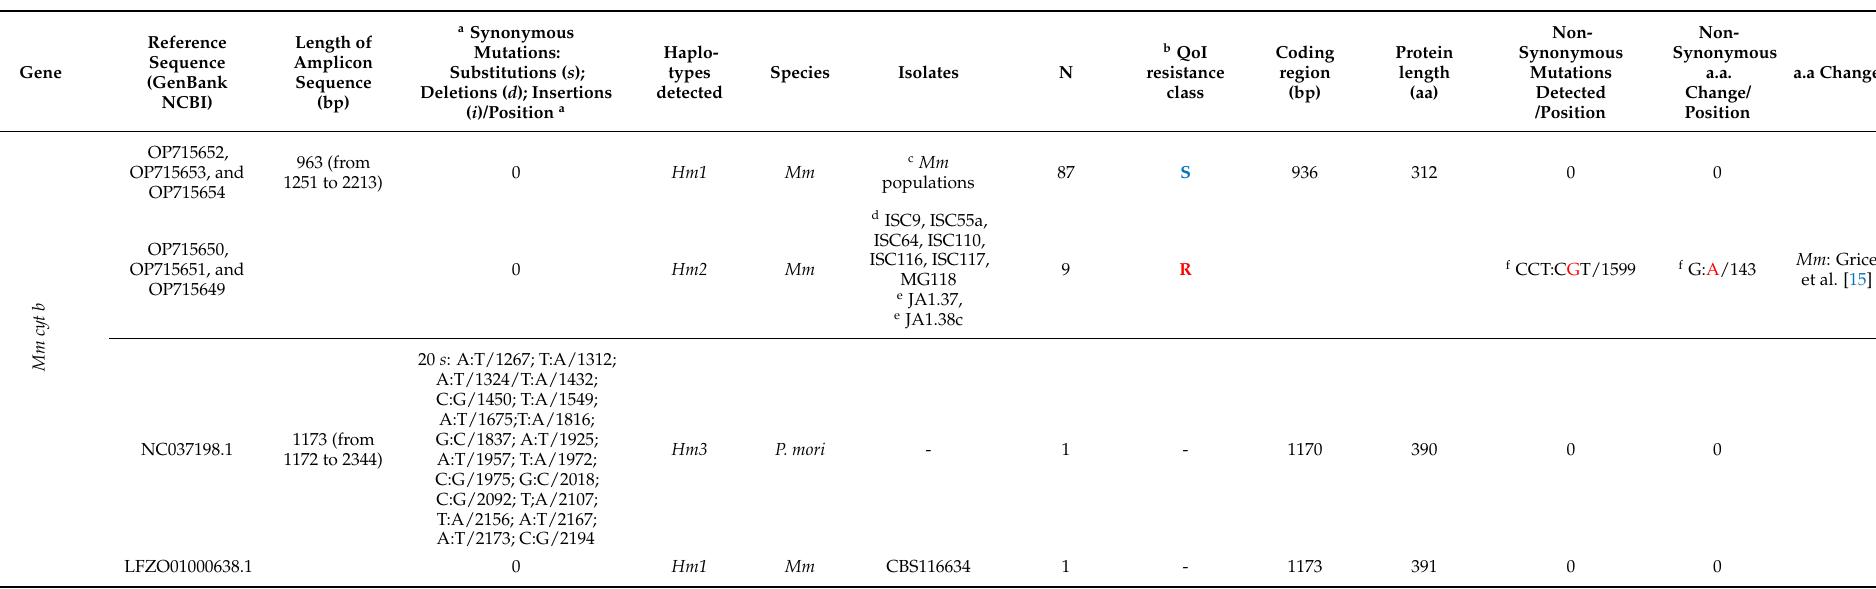
Table 4. Summary of variation at cytochrome b (cyt b) genes from field isolates of Mycosphaerella musicola strains from Brazil with distinct resistance phenotypes to the QoI fungicides azoxystrobin and